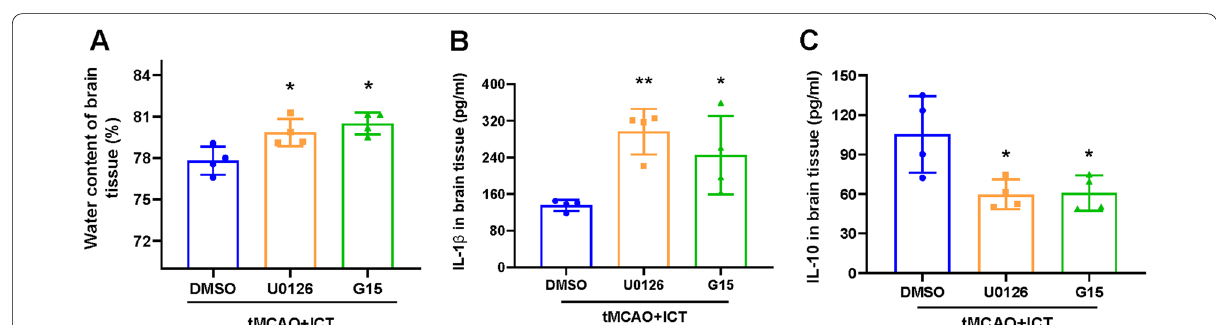
Fig. 6 U0126 and G15 reversed the effect of ICT on reducing brain edema and neuroinflammation in tMCAO rats. A The water content of rat ischemic lateral brain tissue (n 4). B and C IL-1β and IL-10 levels in rat brain tissue in ischemic penumbra area (n = the mean SD, * P < 0.05, ** P < 0.01, compared with tMCAO ICT ± +